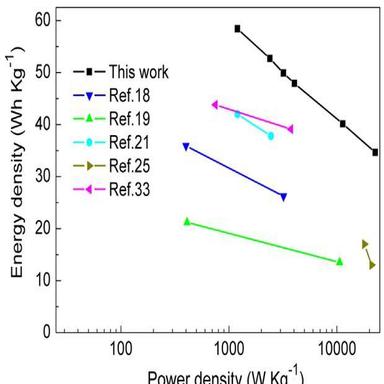
Ragone plot related to energy densities and power densities of the Co (OH)2/RuO2//AC asymmetric supercapacitors cell.